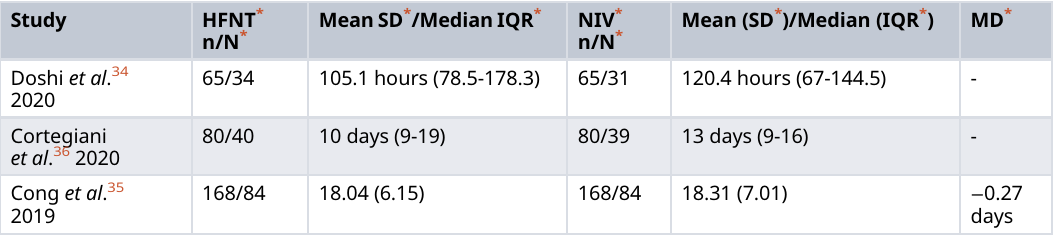
Table 11. Length of